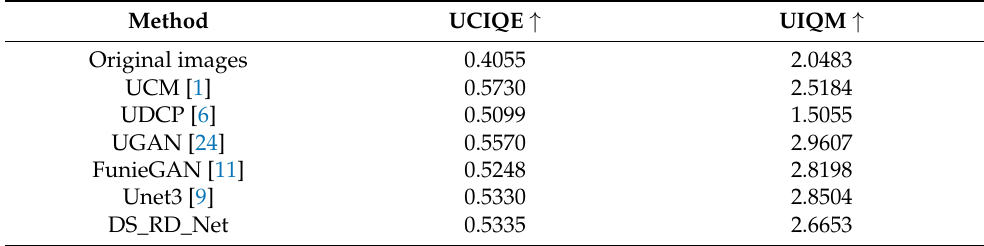
Table 4. Quantitative results evaluation on real underwater datasets by non-reference metrics.